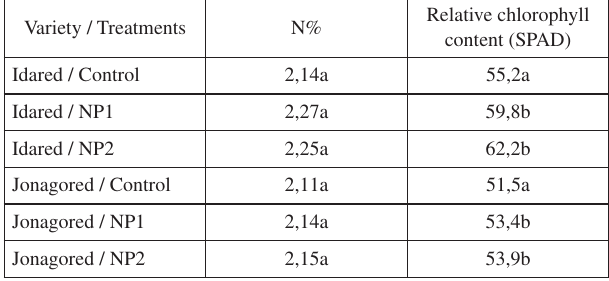
Table 3 . Effect of treatments on leaf relative chlorophyll